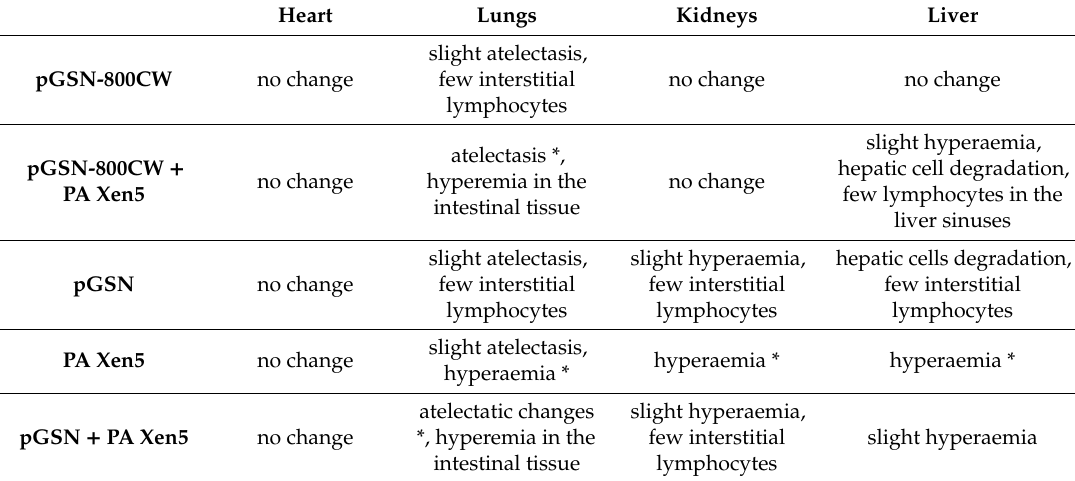
Table 2. Histopathological analysis of organs collected from sacrificed PA Xen5-infected and pGSN-treated animals performed using hematoxylin-eosin staining. Heart Lungs